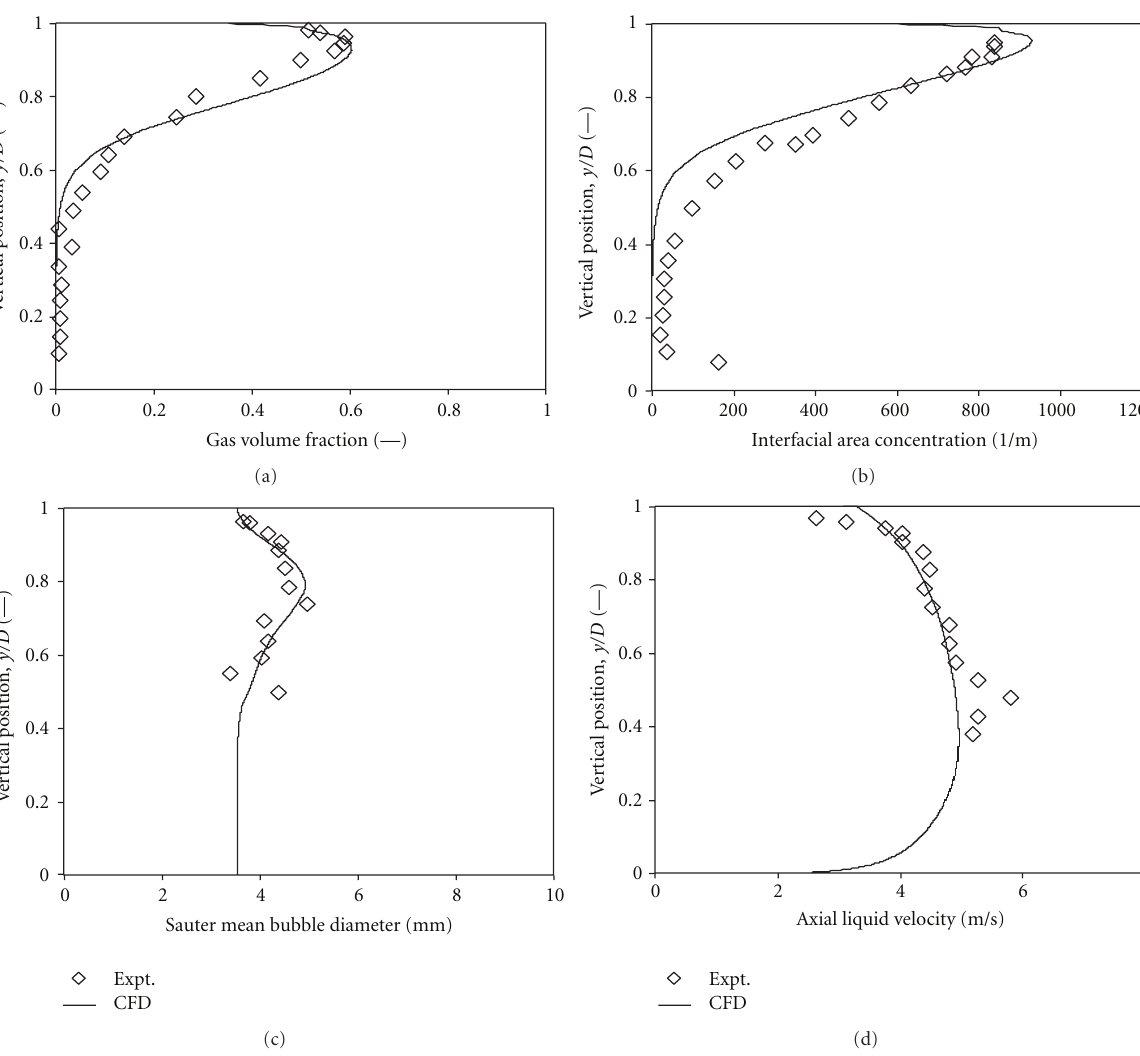
Figure 7: Comparison of predicted and experimental data of Kocamustafaogullari and Wang [17] for superficial gas velocity of 0.51 m/s, superficial liquid velocity of 3.74 m/s, and volume fraction of 0.105: (a) gas volume fraction, (b) interfacial area concentration, (c) Sauter mean bubble diameter, and (d) axial liquid